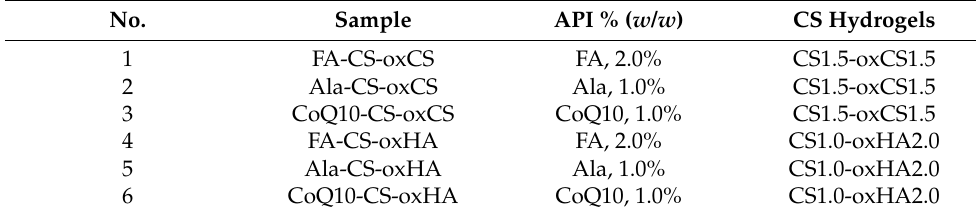
Table 2. The composition of bioactive CS-based hydrogels.